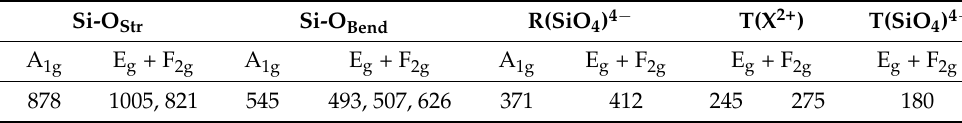
Table 4. Chromium–vanadium grossular Raman spectrum peak Table 4. Chromium – vanadium grossular Raman spectrum peak assignment.